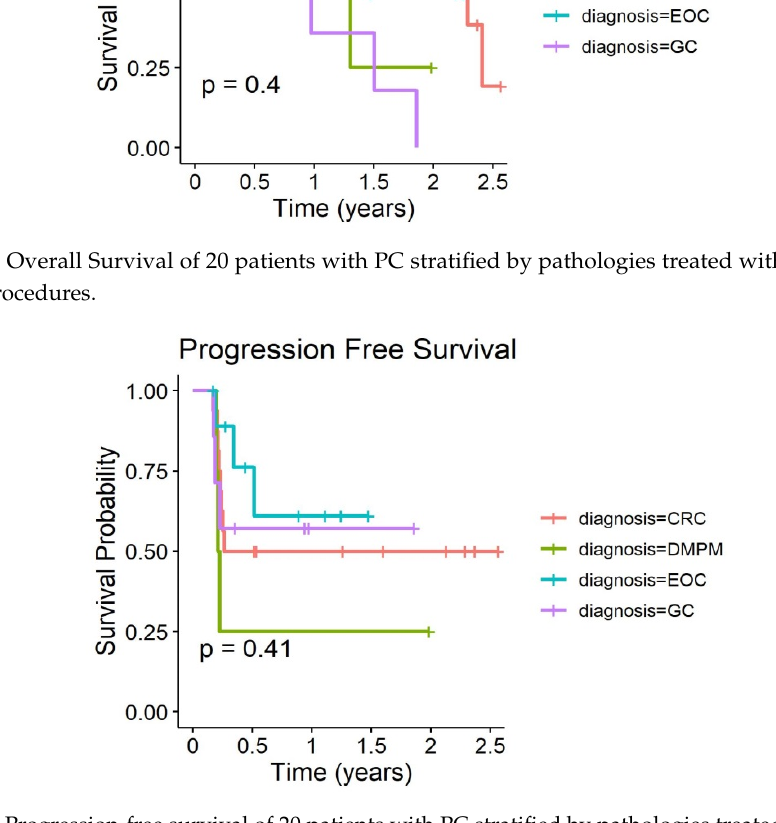
Figure 5. Progression-free survival of 20 patients with PC stratified by pathologies treated with at least two PIPAC